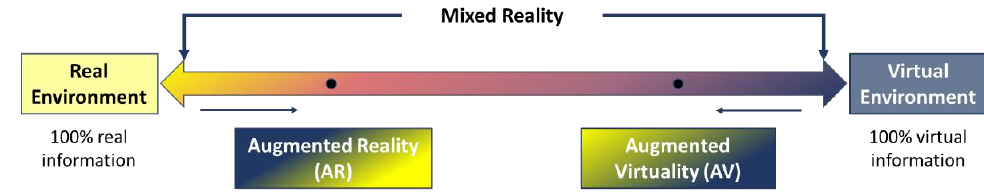
Figure 2. Reality-Virtuality Continuum adapted from [15].